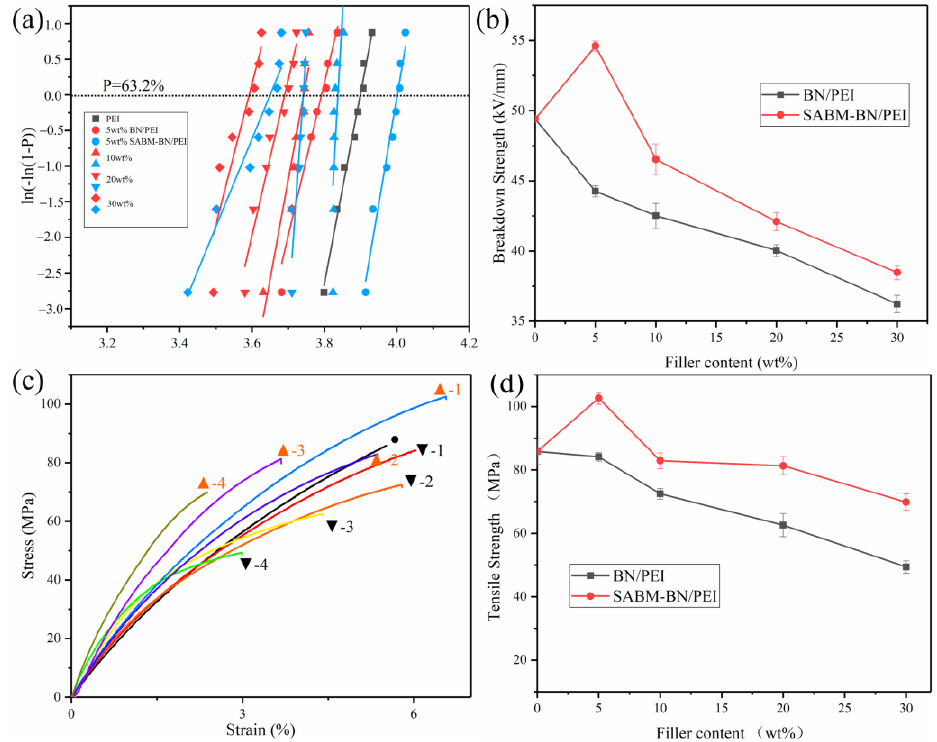
Figure 4. ( a ) Weibull distribution plots and ( b ) breakdown strength of PEI and the PEI composite films. ( c ) The stress-strain curves and ( d ) tensile strength of PEI and the PEI composite films. Black circle: PEI. Downward-facing black triangle 1 – 4: 5~30 wt% BN/PEI composite films. Upward-facing orange triangle 1 – 4: 5~30 wt% SABM-BN/PEI composite films.